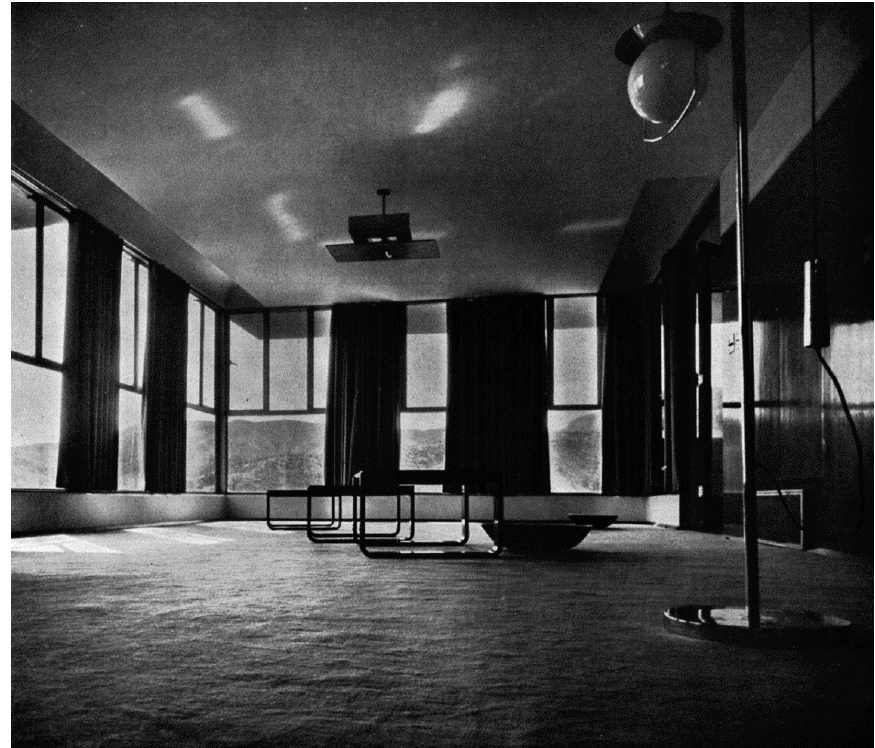
Figure 6. Richard Neutra, Lovell Health House, Los Angeles, 1927–1929. Living room. (Photo by Willard D. Morgan, published in Hoffmann 1932, p. 389, © Barbara and Willard Morgan photographs and papers, Library Special Collections, Charles E. Young Research Library, UCLA).